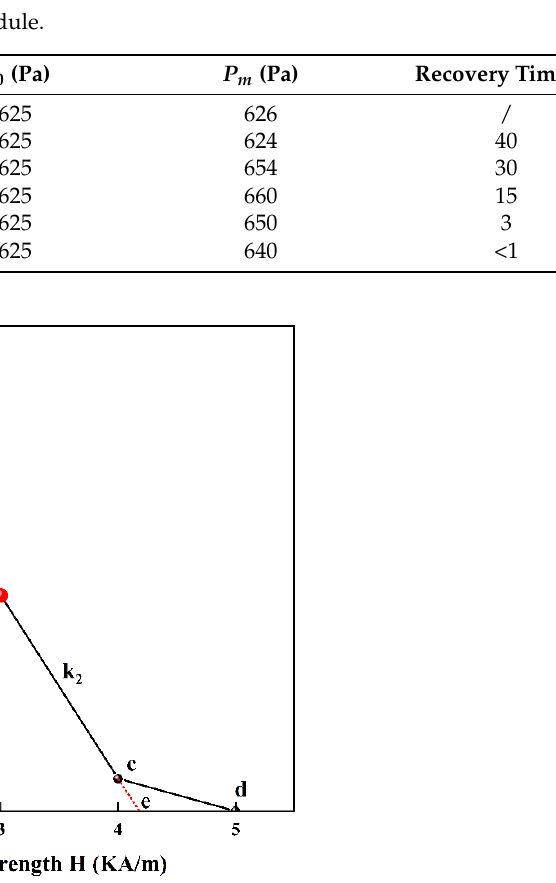
Figure 7. Pressure drop yield time of ‘adding magnetic field later’. ( a–d), are experimental values and e is the predicted value. k 1 is the slope of the ab line, k 2 is the slope of the bc line, and the abso- lute value of k 2 is greater than the absolute value of k 1 .